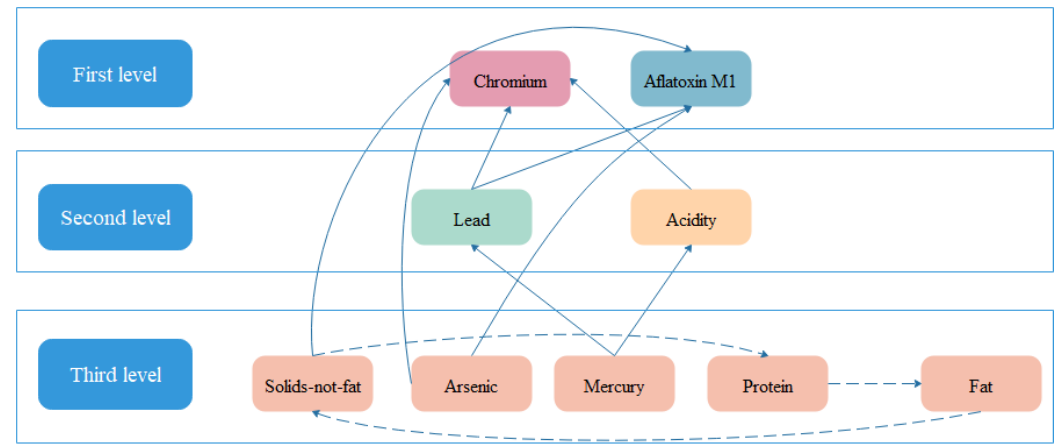
Figure 3. The final hierarchy structure of the main influencing factors of infant milk powder.